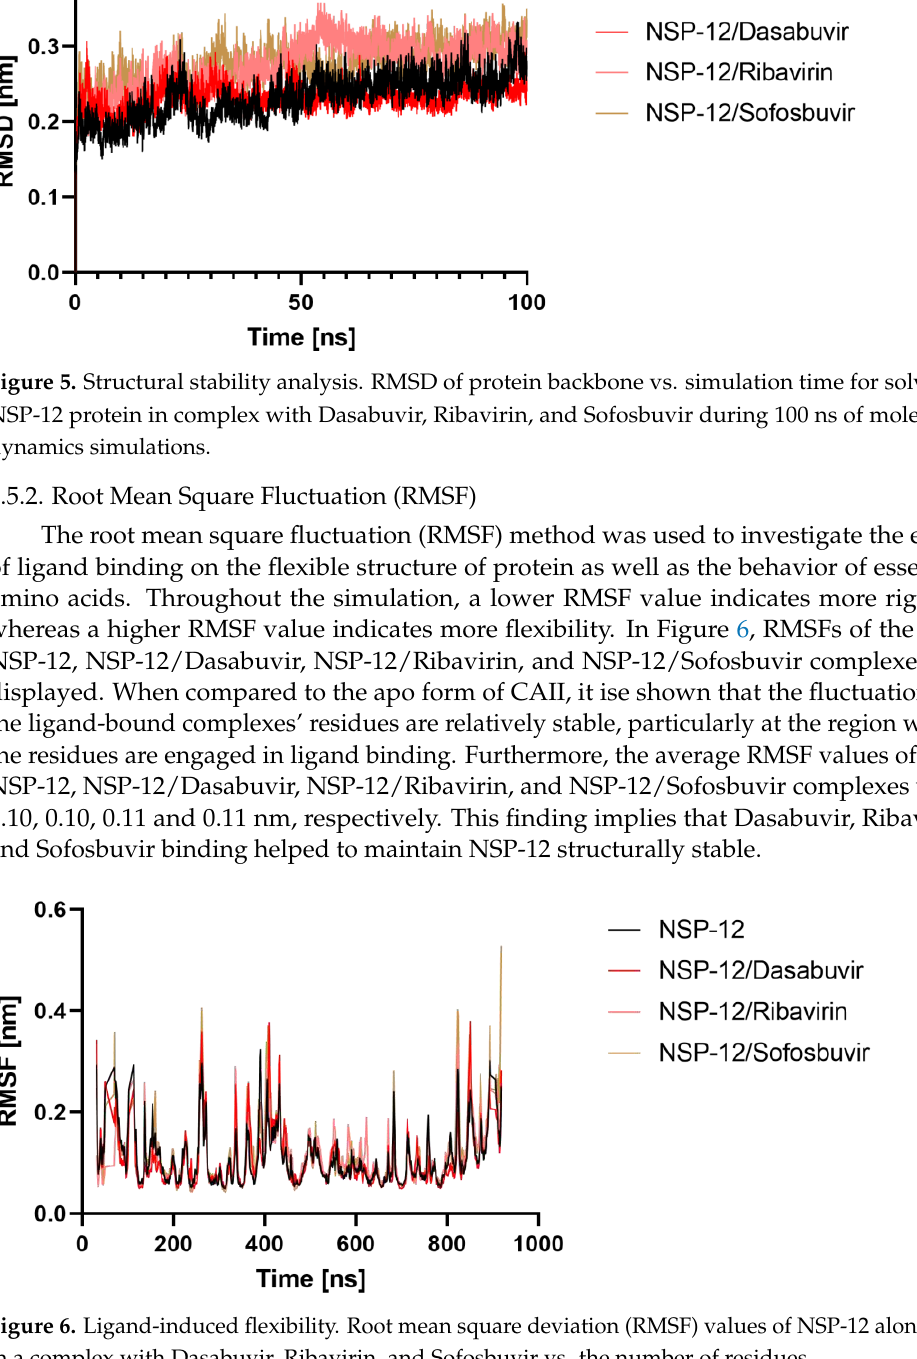
Figure 6. Ligand-induced flexibility. Root mean square deviation (RMSF) values of NSP-12 alone and in a complex with Dasabuvir, Ribavirin, and Sofosbuvir vs. the number of